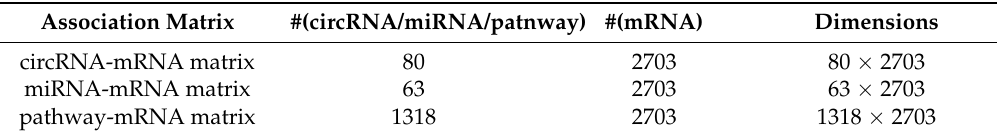
Table 1. Summary information of three characterized binary matrixes.